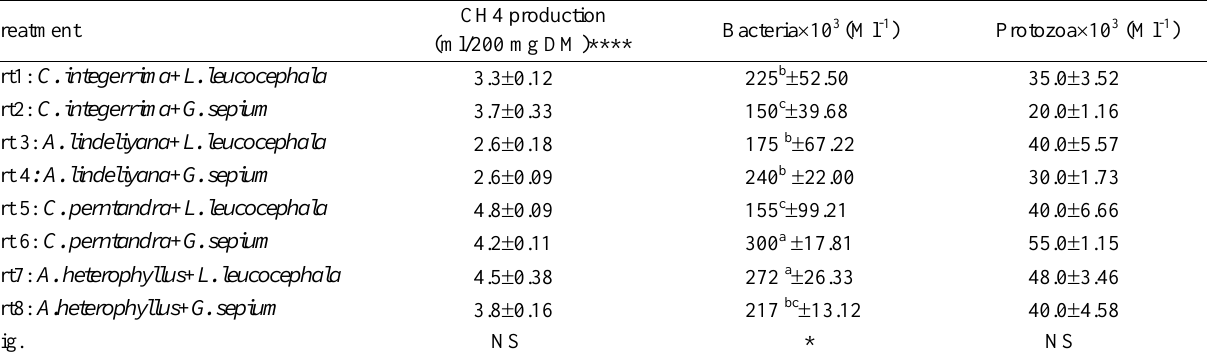
Table 6. Methane production, bacteria and protozoa counts after 48 h (incubation) Treatment